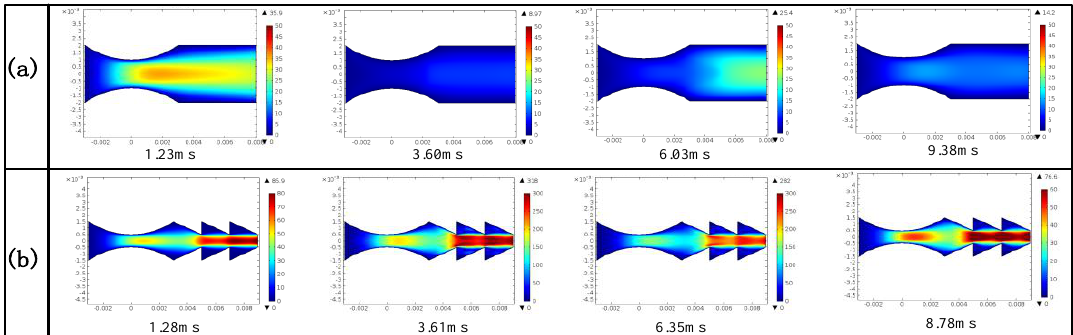
Figure 7. Distribution of airflow at different times in ( a ) basic SSAC; ( b ) optimized SSAC.